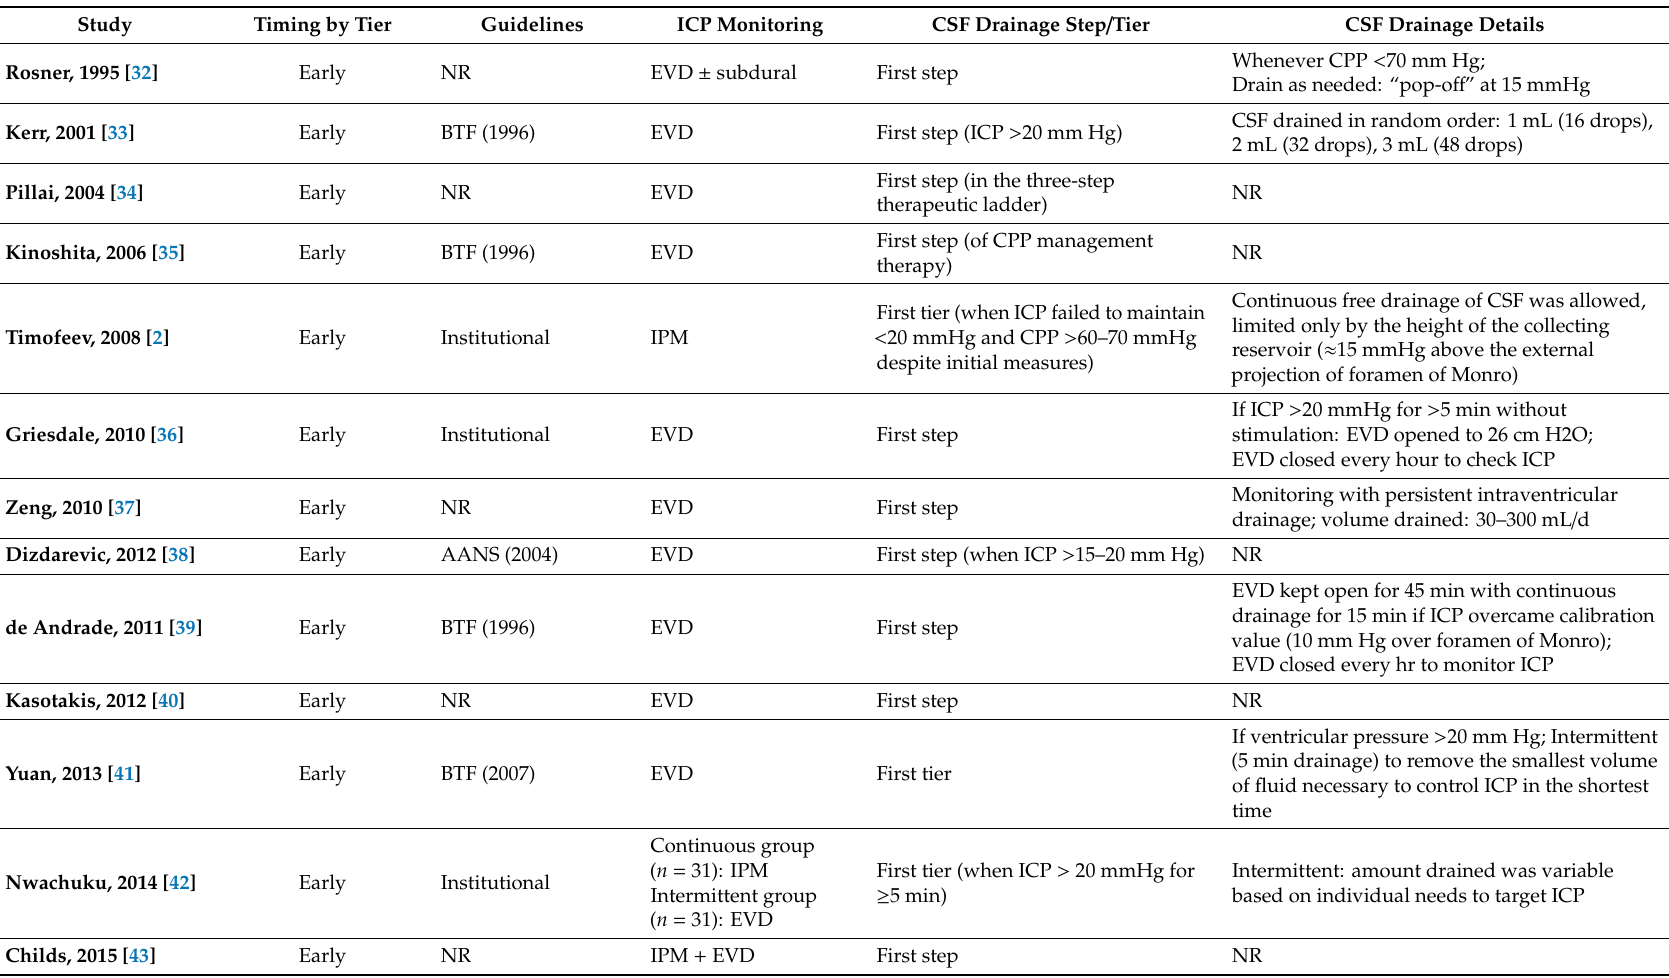
Table 3. ICP monitoring and drainage details of included